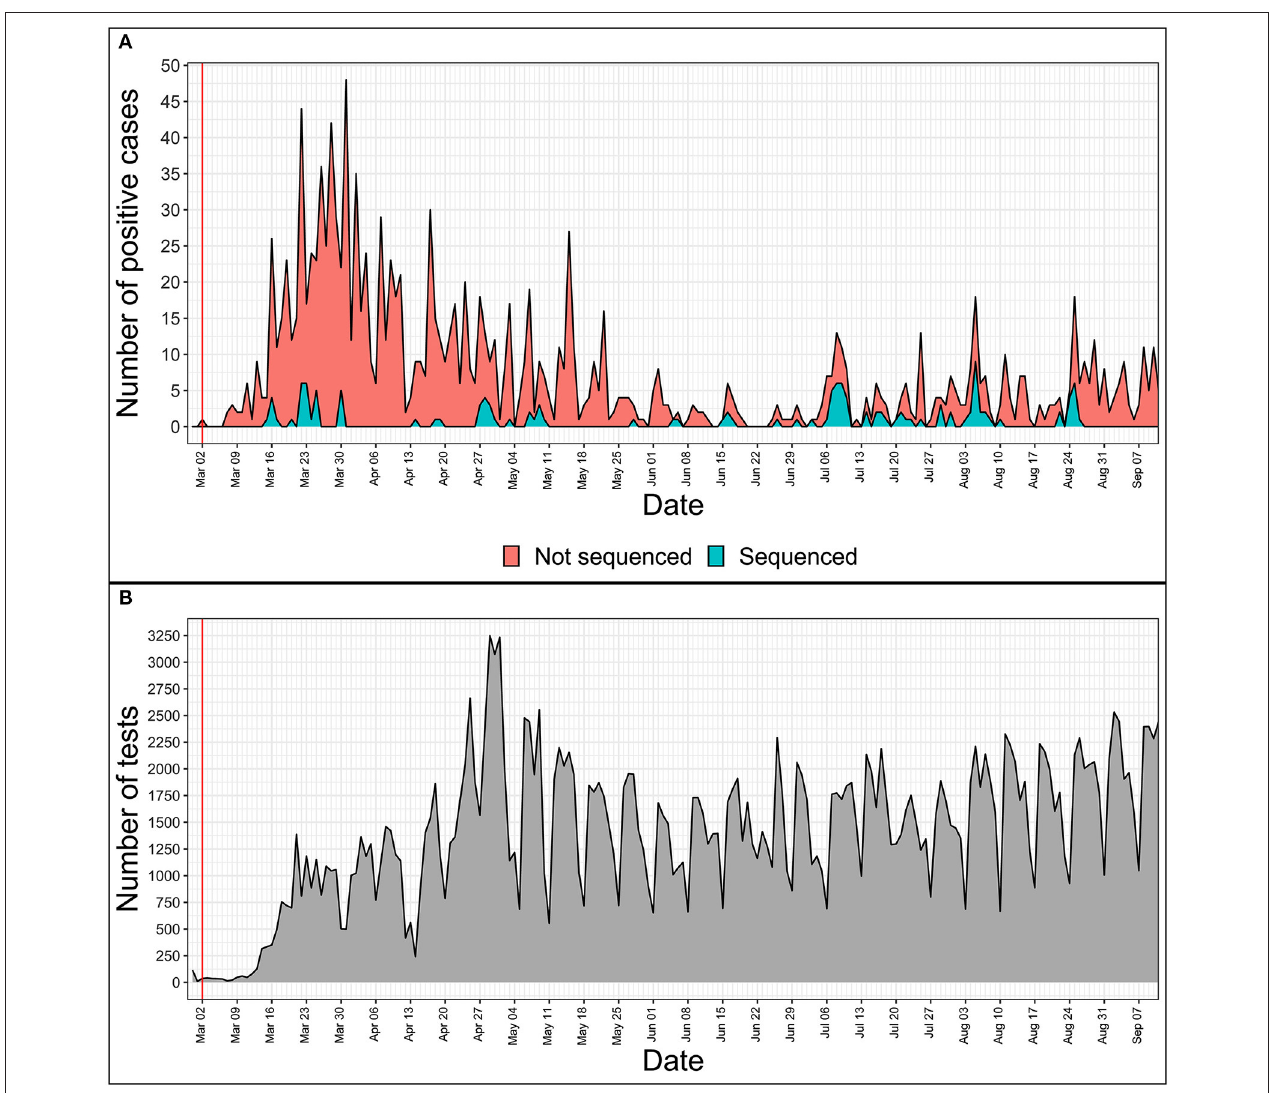
FIGURE 1 | Daily numbers of positive COVID-19 cases (A) and tests performed (B) in Latvia. x -axis is the same for both tiles and represents daily time series from 28th of February, 2020 to 11th of September, 2020. The red vertical line indicates the date of the first COVID-19 case registered in Latvia. (A) Y value represents the total number of positive cases registered on a given day. Blue area shows the number of only successfully sequenced isolates, while the red area represents the positive cases not sequenced during this study. (B) Y value represents the number of tests carried out on a given date in